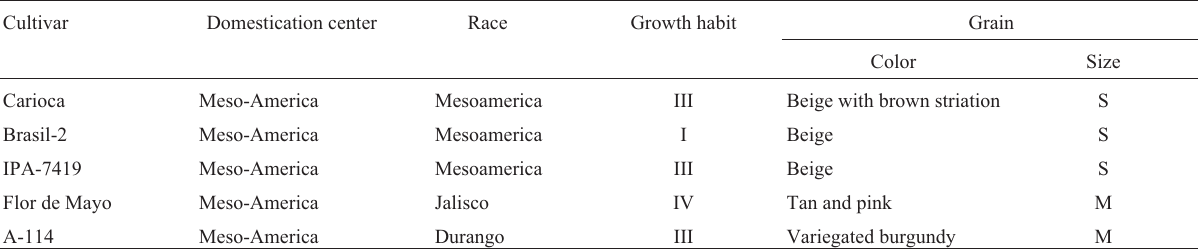
Table I - Traits of common bean cultivars used in the cross. Cultivar Domestication center